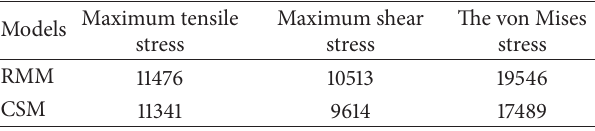
Table 6: Peak stress values of the two models